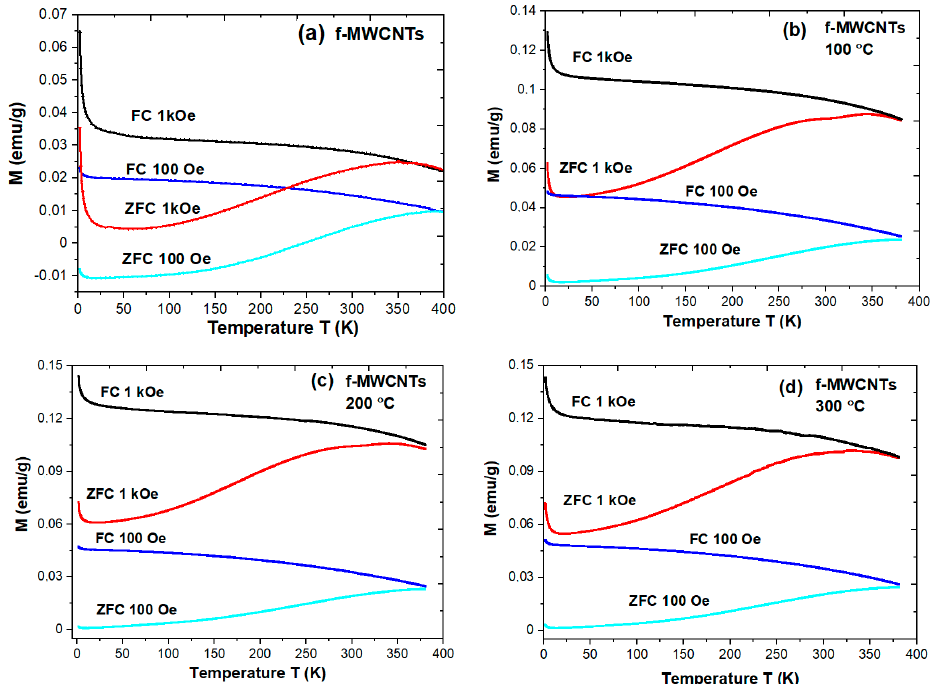
Figure 10. The thermomagnetic dependence of magnetization M(T) measured at 1 kOe and 100 Oe for f-MWCNTs: ( a ) pristine; ( b ) calcined at 100 °C; ( c ) calcined at 200 °C; ( d ) calcined at 300 °C. The M ZFC (T) high-temperature measurements performed for pristine and calcined at 300 °C nanotubes allow determining the phase transition temperature for magnetic com- ponent dominated in f-MWCNTs. Between 400–500 K, the evident phase transition can be noted. The performed dM/dT differentiation allows estimating the value of the Curie tem- perature, which equals T C ≈ 452 ± 15 K. As previously discussed, in the studies samples, we can distinguish several types of Fe-based structures with the evident influence of Fe 3 C. Cementite is a metallic ferromagnet transforming to the paramagnetic state at a Curie temperature of about T C = 483 K [67]. In our case, such temperature is lower, but as evi- denced, the presence of other magnetic Fe-based components cannot be neglected. Indeed, Lee et al. [68] revealed the magnetic phase transition for goethite ( α -FeOOH) and lepido- crocite ( γ -FeOOH) nanoparticles. Both crystallize in the orthorhombic structure and show the antiferromagnetic arrangement with the Néel temperature T N = 252 K and 53 K, re- spectively. Such values are lower than bulk materials, e.g., for bulk α -FeOOH, it equals about T N = 372 K [69]. Thus, the origin of the broad peak observed for f-MWCNTs may comprise the overlapped magnetic phase transition of dominated cementite and partly goethite. The influence of lepidocrocite is low and can be noted by a weak inflexion point around 50 K. However, there is an additional peculiarity between 750 K and 850 K as the induced heat-treatment phase transition during heating the sample under measurements conditions above 300 K. As evidenced by Boi et al. [70], the decomposition of γ -Fe into α - Fe starts even at temperatures below 200 °C and is significantly faster in the temperature range of 300–399 °C. However, such a phenomenon occurs in a strictly controlled envi- ronment without possible oxidation. The magnetic transition presented in Figure 11 at high temperatures is lower than for typical α -Fe, which may indicate that the Fe-oxides are probably generated during measurements.